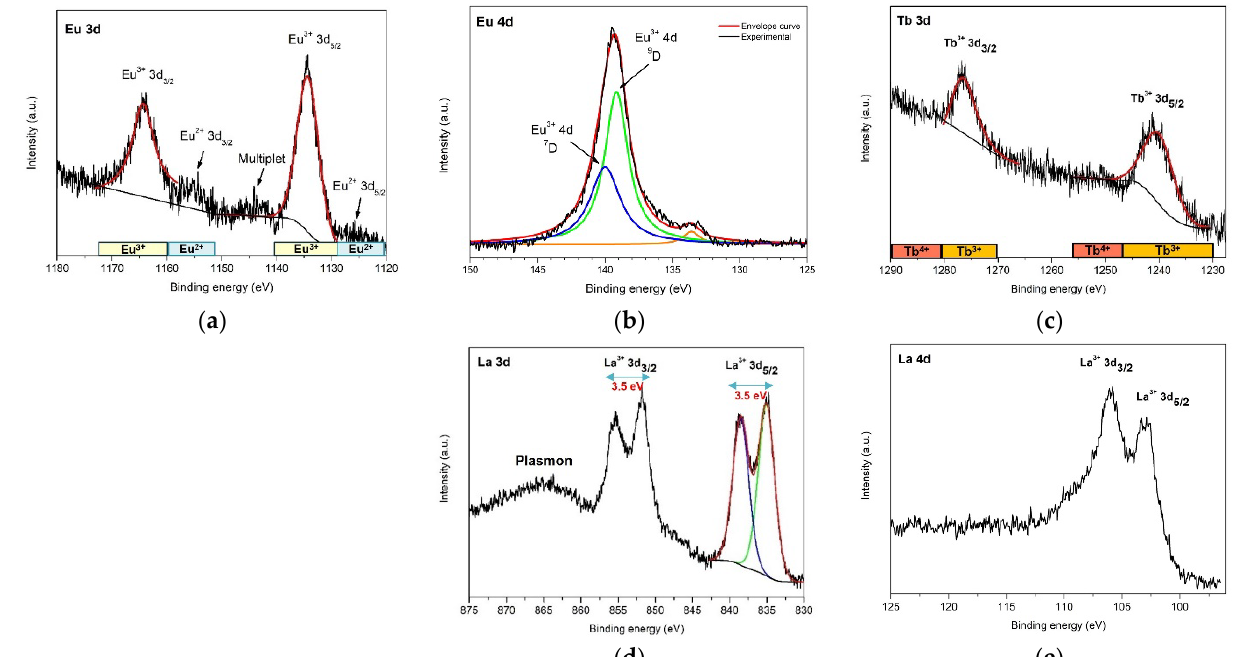
Figure 6. ( a ) HRXPS spectra of Eu 3d core-level photoelectron line from sample ZnO:Eu; ( b ) Eu 4d core-level photoelectron line from sample ZnO:Eu; ( c ) Tb 3d core-level photoelectron line from sample ZnO:Tb; ( d ) La 3d and ( e ) La 4d core-level photoelectron lines from sample ZnO:La.